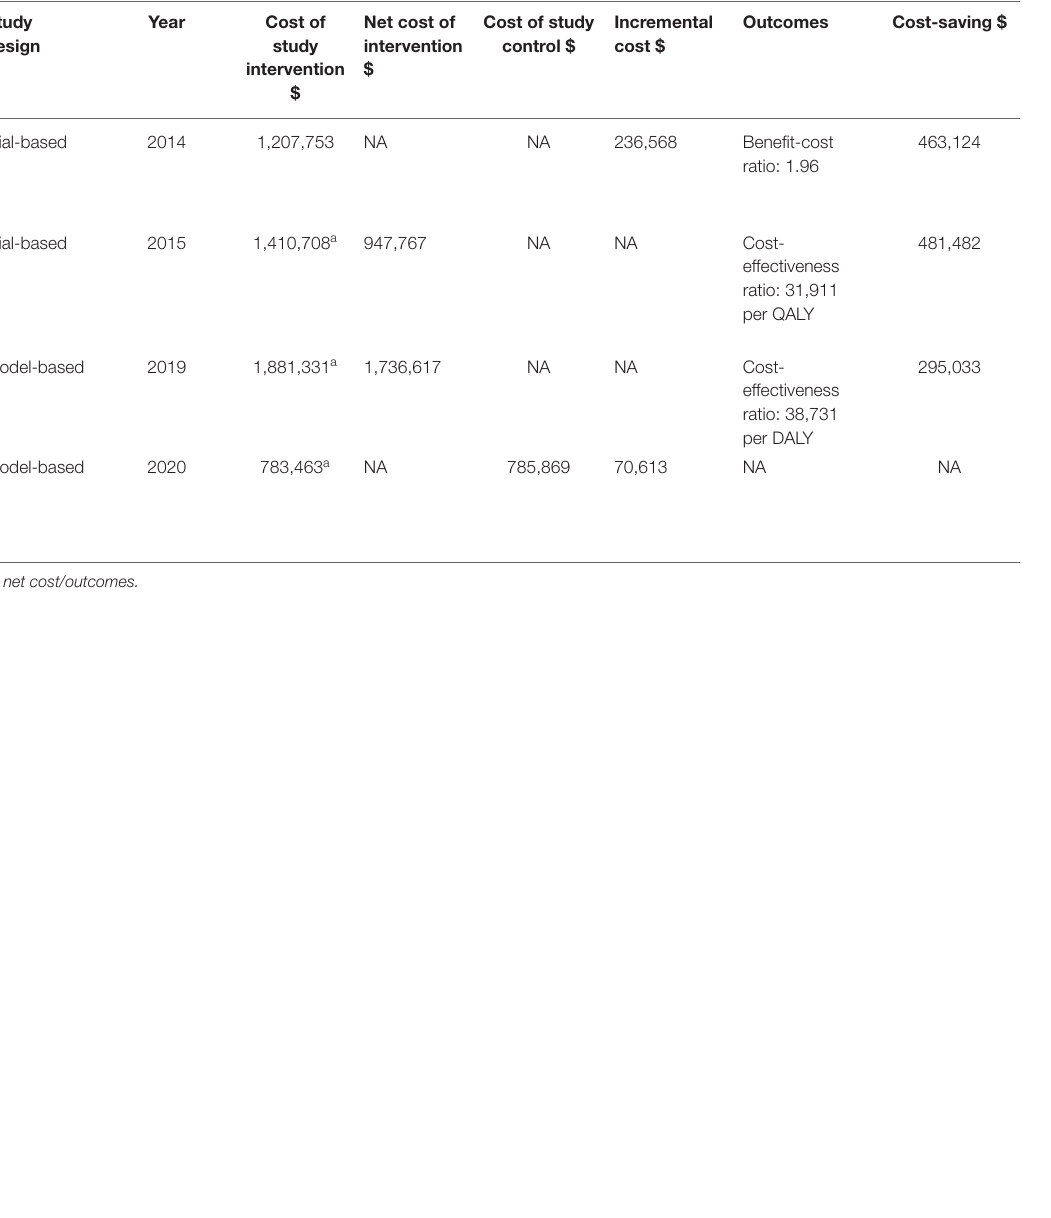
TABLE 2 | The general characteristics of the included economic